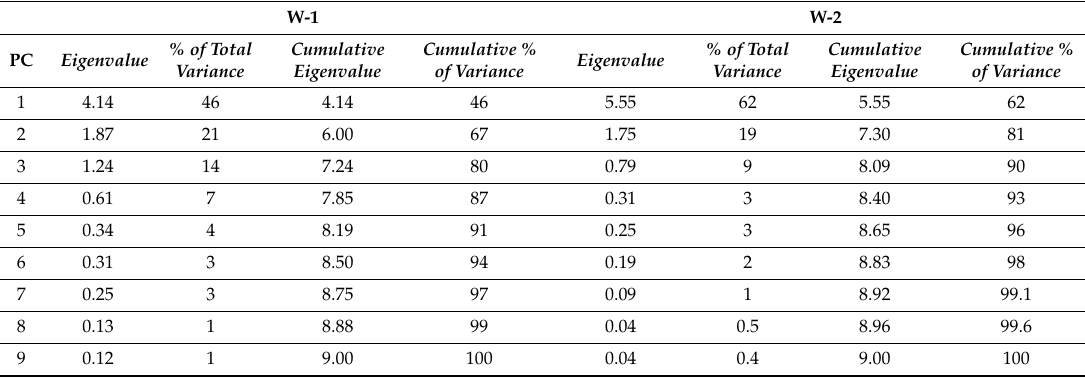
Table 1. Eigenvalues and percentage of variance, W-1 and W-2